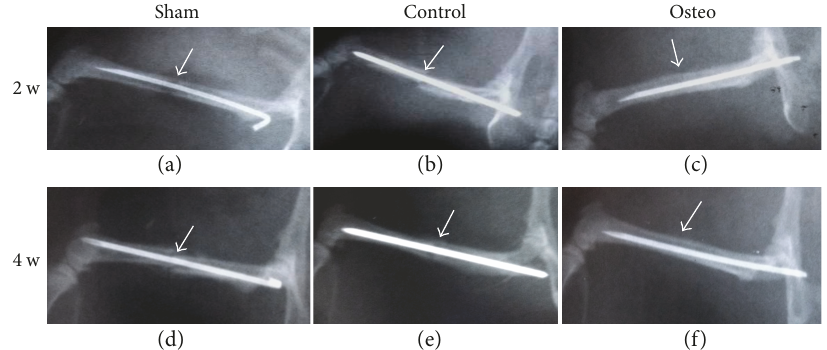
Figure 6: Radiographs taken at second (a, b, c) and fourth weeks (d, e, f) after MSC sheet transplantation. Radiographs supported the gross morphological and histological fi ndings. Sham: operated but not treated with any MSC sheet. Control: operated and treated with MSC sheets maintained in basal medium supplemented with only ascorbic acid. Osteo: operated and treated with MSC sheets maintained in osteogenesis- stimulating